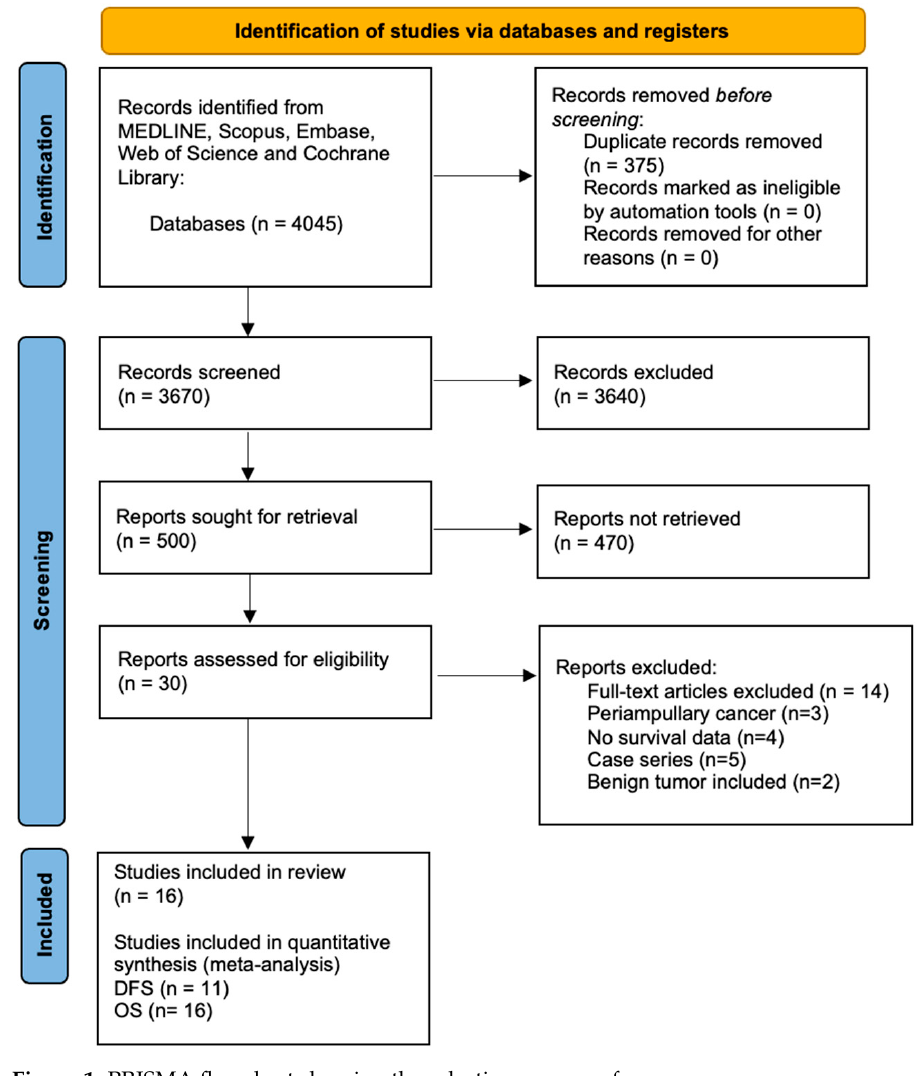
Figure 1. PRISMA flowchart showing the selection process of papers.